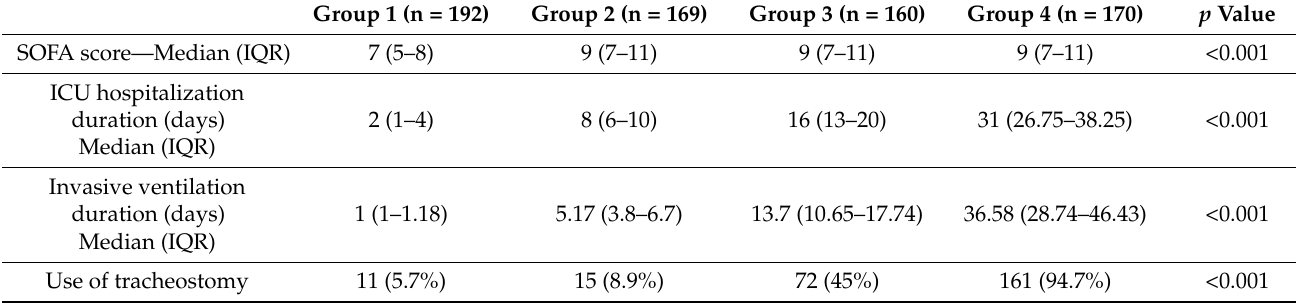
Table 2. Hospitalization data according to the duration of invasive mechanical ventilation.